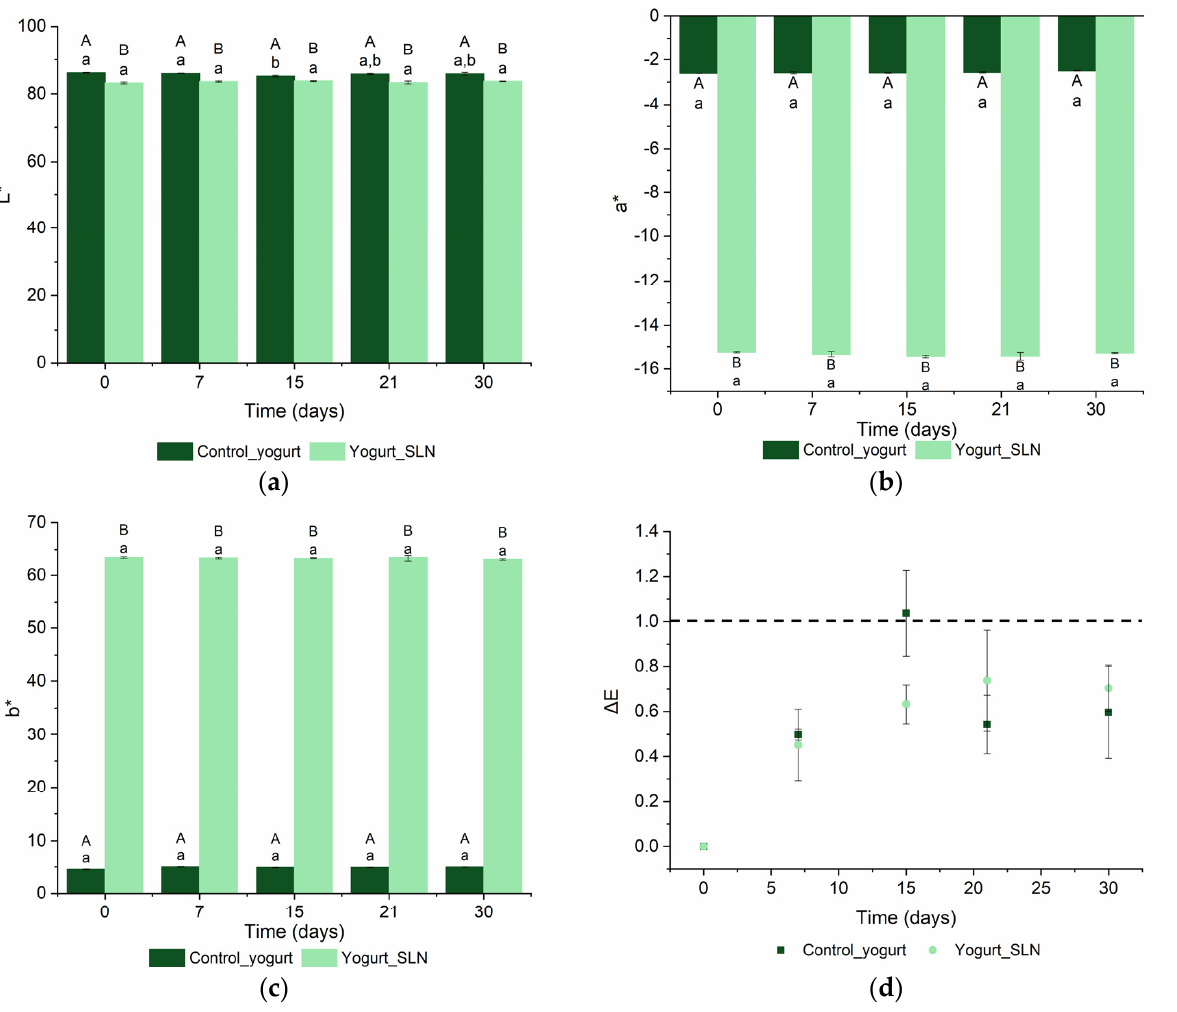
Figure 3. Color parameters: L* ( a ), a* ( b ), b* ( c ) and total color difference ( Δ E ) ( d ) of control yogurt (i.e., plain yogurt) and yogurt with SLN s during shelf-life. a–b Different lower-case letters indicate a statistically significant difference over time for the same sample ( p < 0.05). A–B Different uppercase letters indicate a statistically significant difference between samples for the same time ( p < 0.05).